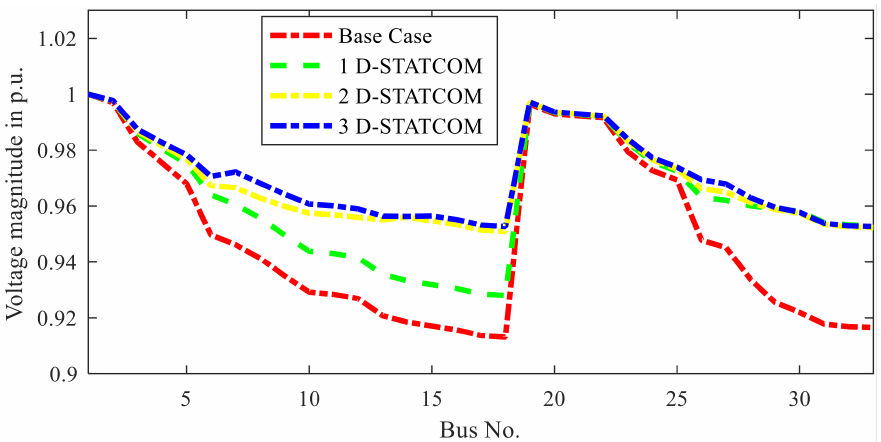
Figure 15. Comparison of voltage profile with and without D-STATCOMs of 33-bus